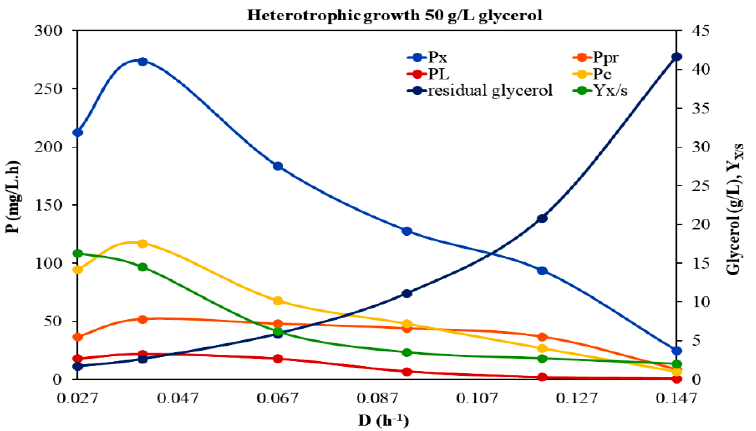
Figure 2. Effect of D on the growth of A. protothecoides under heterotrophic conditions in BBM modified medium with initial glycerol concentration of 50 g/L. Τ he variation in biomass productivity P x (mg/L.h), lipids productivity P L (mg/L.h), proteins productivity P Pr (mg/L.h), carbohydrates productivity P C (mg/L.h) residual glycerol and Y x/S , with D, are displayed. Τ he Y x/S has been increased a hundredfold (100 g/g).